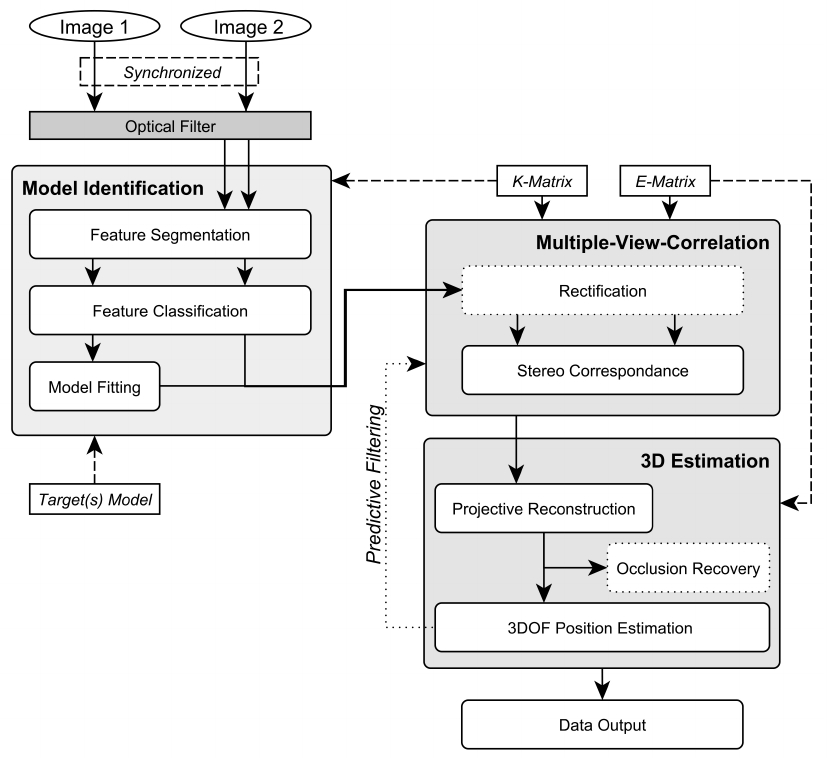
Figure 10. Tracking